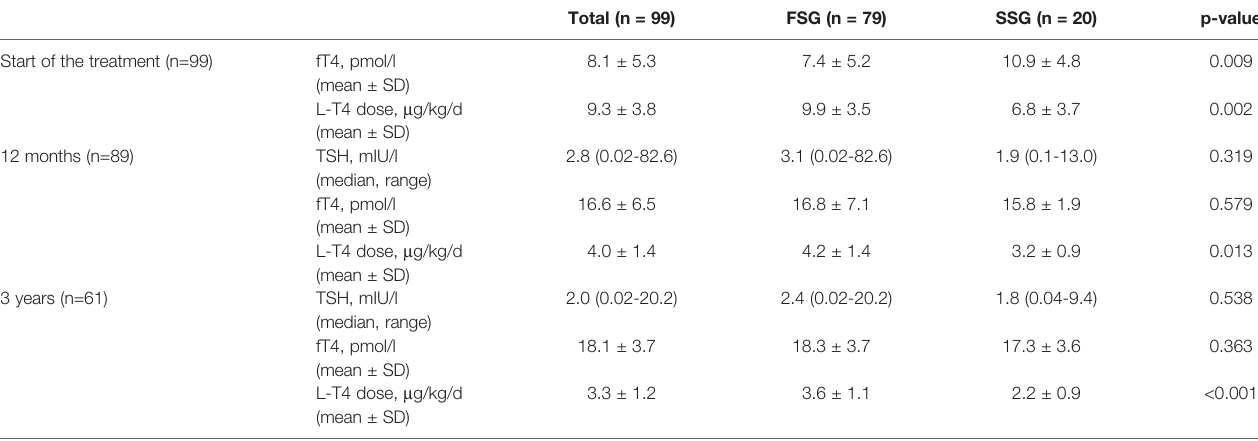
TABLE 3 | Thyroid function test results and levothyroxine treatment at the start of the treatment, after 12 months and 3